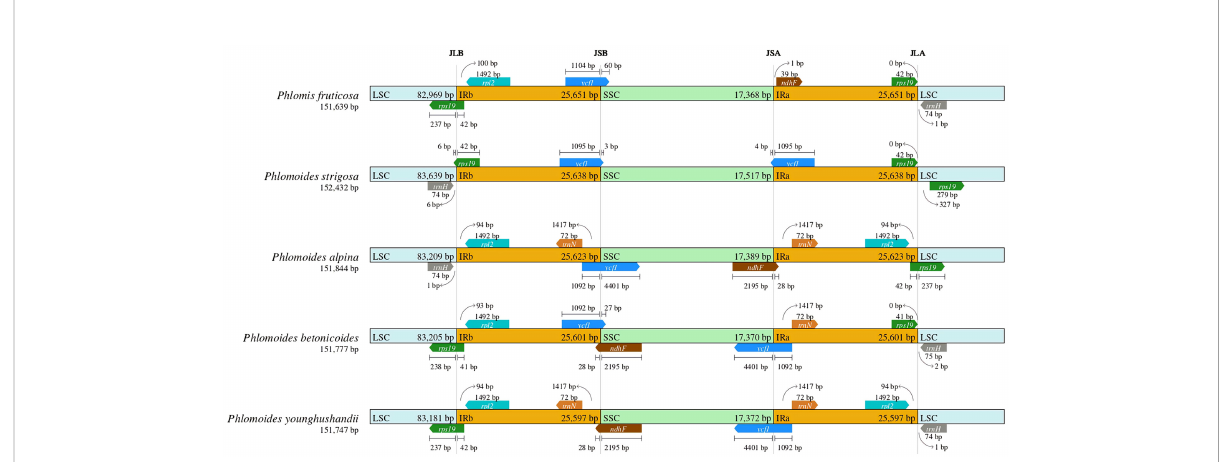
FIGURE 6 Comparison of border distance between adjacent genes and junctions of the LSC, SSC and two IR regions among the chloroplast genomes of Phlomis fruticosa and four Phlomoides species. The species names and the length of chloroplast genomes are depicted on the left of each track. Boxes above or below the main line indicate the adjacent border genes. Genes transcribed forward and reverse strands are presented above and below the tracks, respectively. The arrows indicate the bp distance of the start or end coordinate of genes from the corresponding junction site. For the genes extending from a region to another, the T bar on the top or below shows the extent of their parts with their corresponding values. This fi gure does not re fl ect the scale with respect to sequence length, but only shows relative changes at or near the IR/ SC borders. LSC, large single-copy region; SSC, small single-copy region; IR, inverted repeated region; JLA, junction of LSC and IRa; JLB, junction of LSC and IRb; JSA, junction of SSC and IRa; JSB, junction of SSC and IRb. .